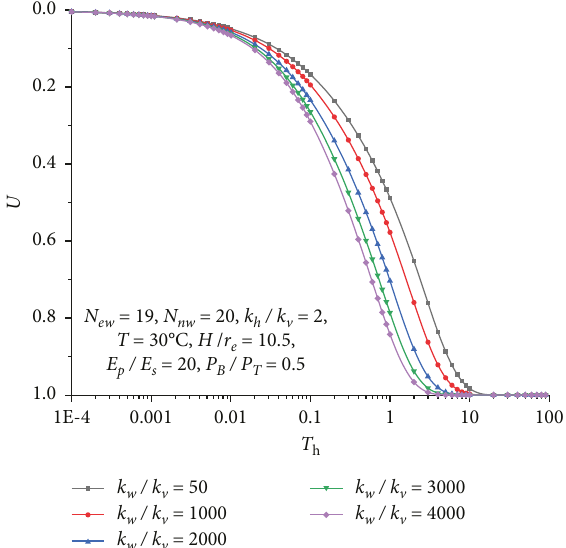
Figure 7: Influence of well resistance on consolidation